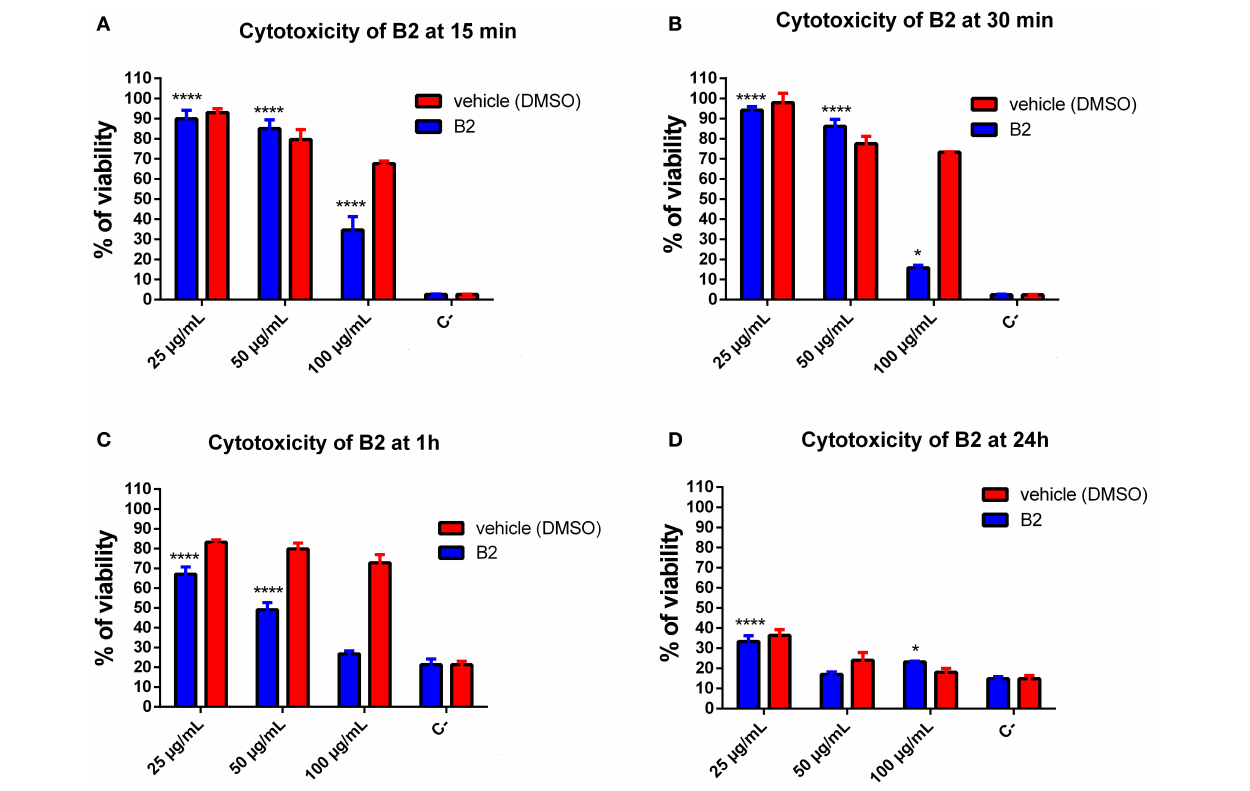
FIGURE 4 | Quantification of B2 cytotoxicity in HeLa cells. Cytotoxicity assay was performed using the MTT Cell Growth Kit. HeLa cells were incubated with B2 (25 µ g/mL or 50 µ g/mL) for 15 (A) , 30min (B) , 1 (C) , and 24h (D) at 37 ◦ C. Percentages are corrected based on the viability control (culture medium alone). The significant difference is based on the negative control (DMSO 100%). A 2-way ANOVA was performed with Tukey’s posttest as a statistical analysis. Only relevant differences are depicted in the figure. * p < 0.05, **** p < 0.0001. n = 3 (biological triplicate).